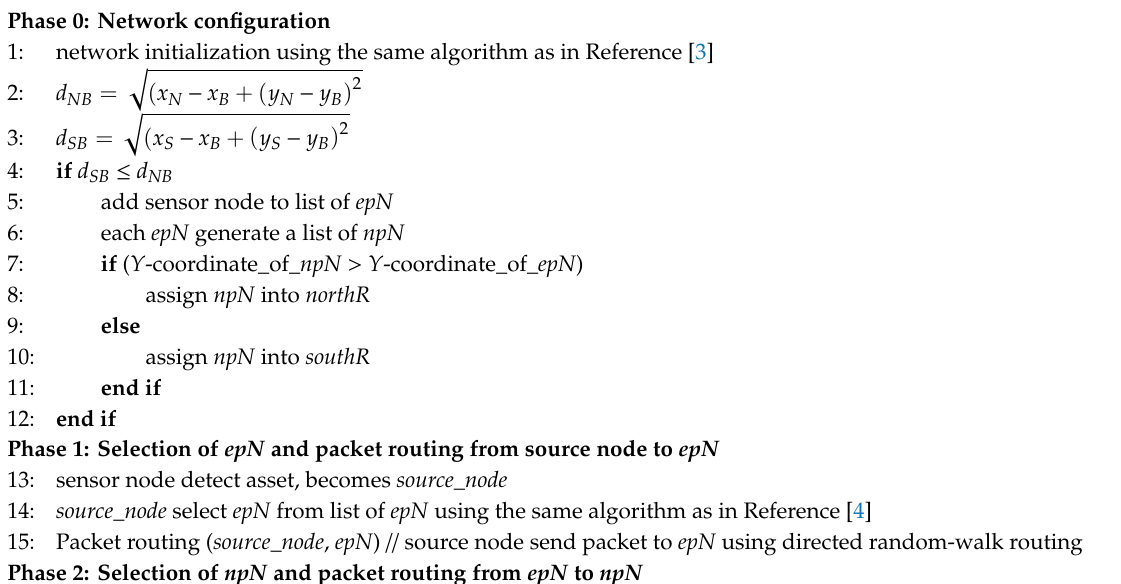
Algorithm 2. Proposed algorithm for the PhaT